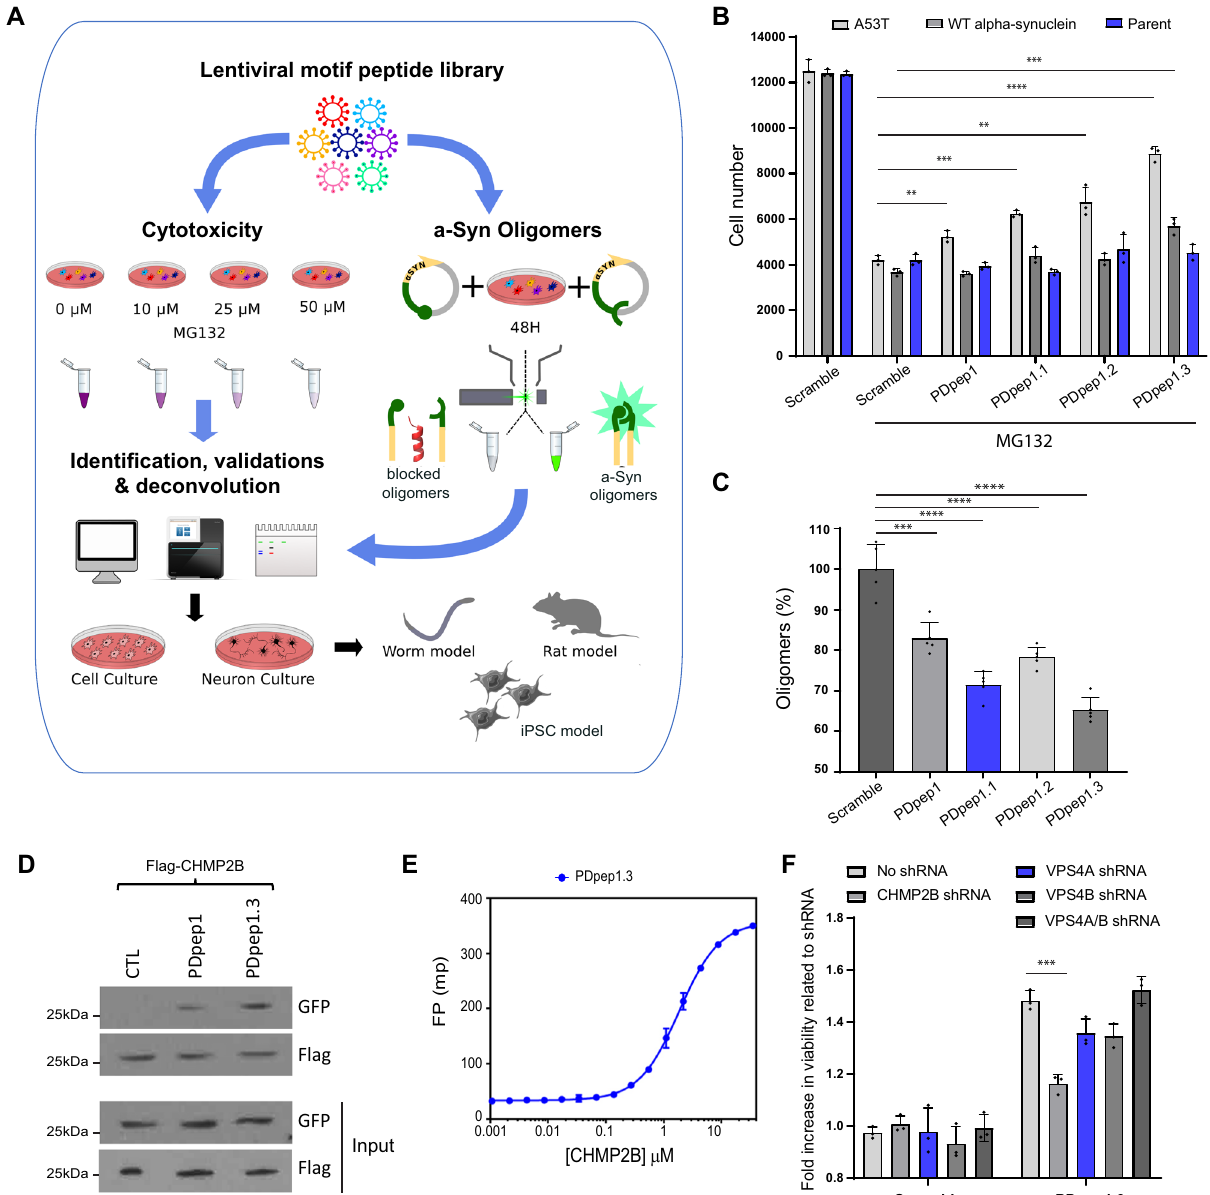
Fig. 1 | Proteomic screens and in vitro validation of hits. A Schematic of the experimental design including proteomic screens, identi fi cation and validation of hits,targetdeconvolution, andevaluationincelland animalmodels (createdusing Servier Medical Art at https://smart.servier.com/). For the cytotoxicity screen, we employedourpeptide librarytoidentify peptidesthat rescue cytotoxicity induced by a-syn overexpressionand proteostaticstress (due to MG132administration).To screen our library for peptides that inhibit a-syn oligomers, we used FACS with a split YFP-a-syn system (cells co-expressing V1S and SV2). B Validation of cell viabilityeffectofpeptidesinA53TandWTa-synexpressingcellsunderproteostatic stressaswellascontrols.MG132wasusedataconcentrationof10 μ M.Experiments were done in triplicate. Data represent means±s.d. (unpaired two-tailed t -tests; A53T PDpep1, P =0.0051; A53T PDpep1.1, P =0.0002; A53T PDpep1.2, P =0.0035; A53T PDpep1.3, P < 0.0001; WT a-syn PDpep1.3, P =0.0008; n =3). C WT a-syn oligomers as measured by luciferase activity. All four peptides showed signi fi cant